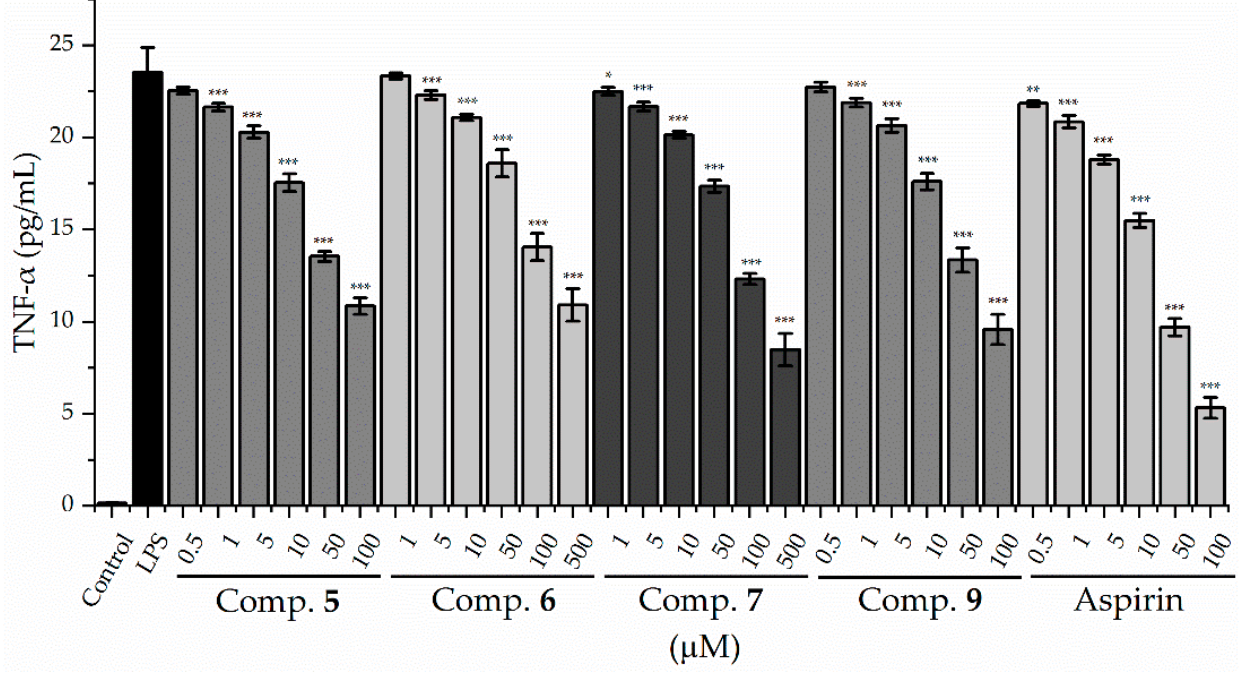
Figure 4. Effects of compounds 5–7 and 9 on TNF- α production in LPS-stimulated raw 264.7 cells. * p < 0.05, ** p < 0.01, and *** p < 0.001 compared with LPS-stimulated group. Aspirin (positive control).